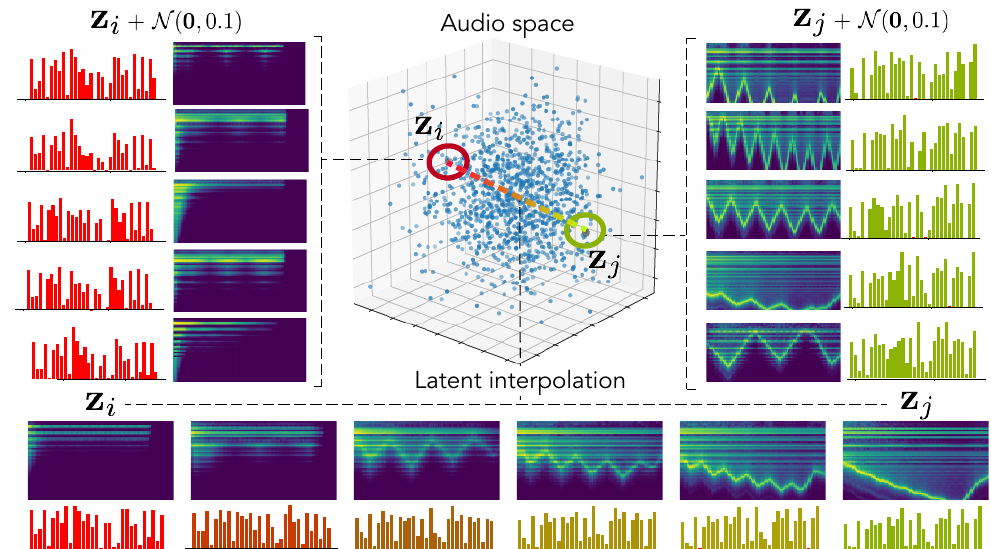
Figure 4. Latent neighborhoods . We select two examples from the test set that map to distant locations in the latent space z and perform random sampling in their local neighborhood to observe the parameters and audio. We also display the latent interpolation between those points.